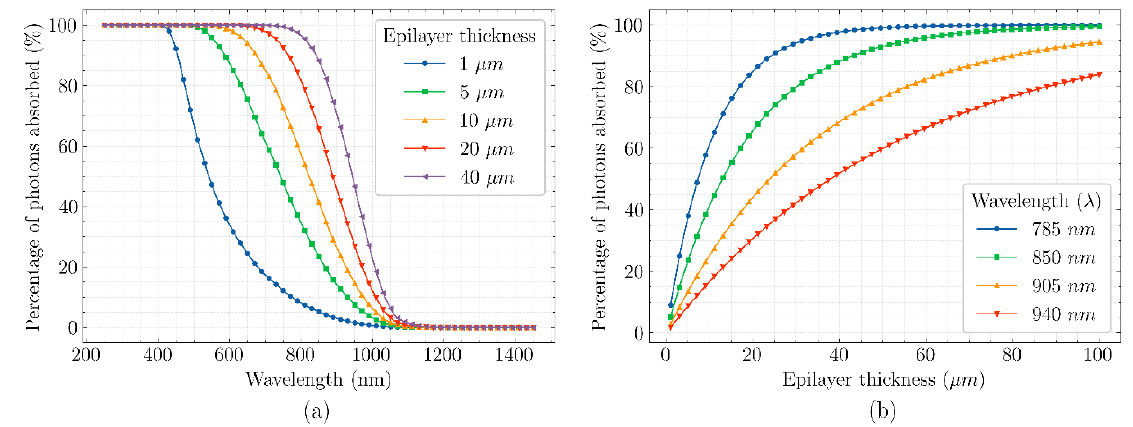
Figure 1. Absorption percentage in Silicon as a function of wavelength for different epilayer thicknesses ( a ) and absorption percentage in silicon as a function of epilayer thickness for a few wavelengths ( b ) (Absorption coefficient data from [27]).